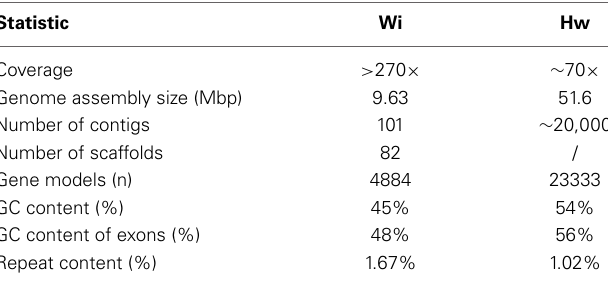
Table 1 | Genome statistics for W. ichthyophaga and H. werneckii (after Lenassi et al., 2013; Zajc et al.,